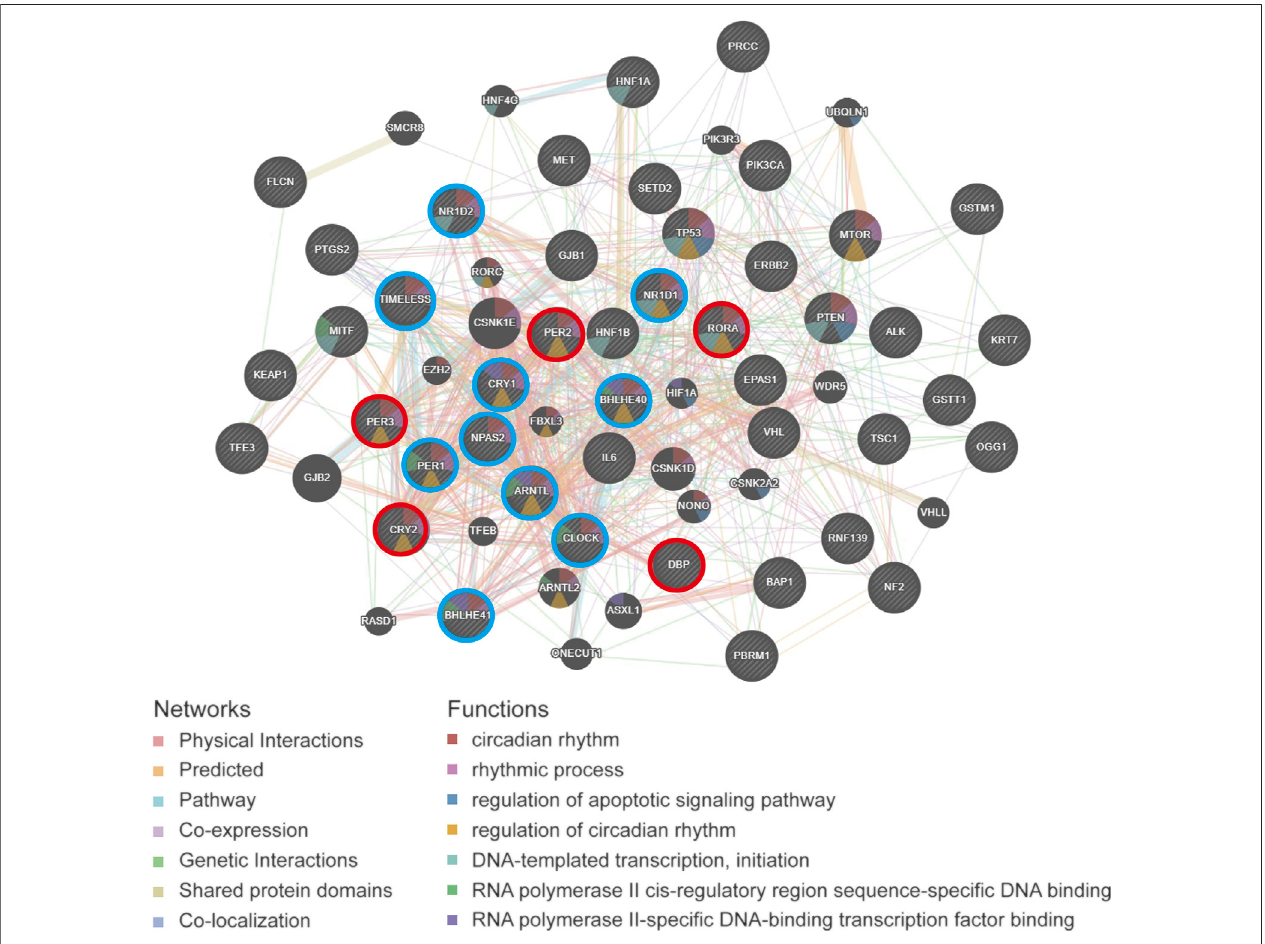
FIGURE9| ThePPInetworkanalysisofcircadianrhythmgeneandcancer-relatedgeneofpan-RCC.ThePPInetworkdiagramshowsthetop30nodesintermsof correlation, of which fi ve prognostic core clock genes and other clock control genes are circled in red and blue, respectively.